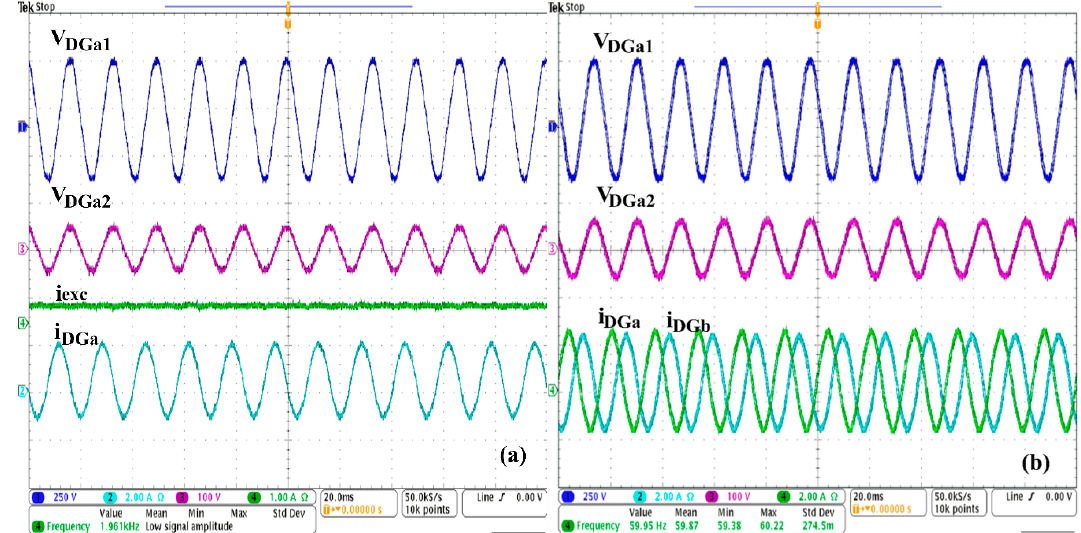
Figure 17. Experimental results under the presence of linear load at ( a ) excitation circuit and, ( b ) PCC.